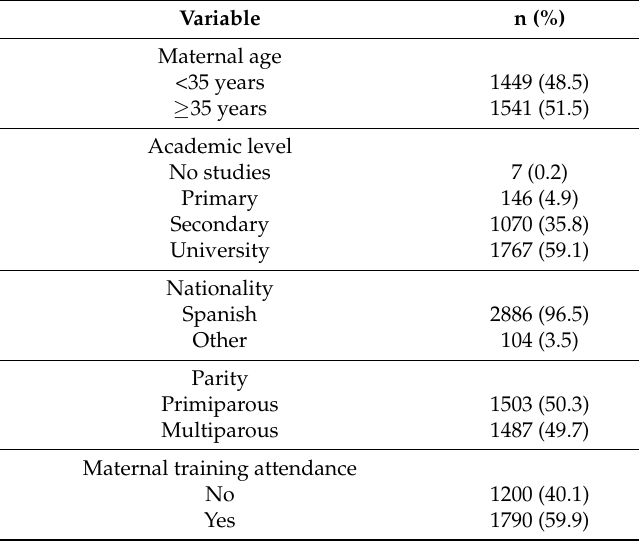
Table 1. Characteristics of the study